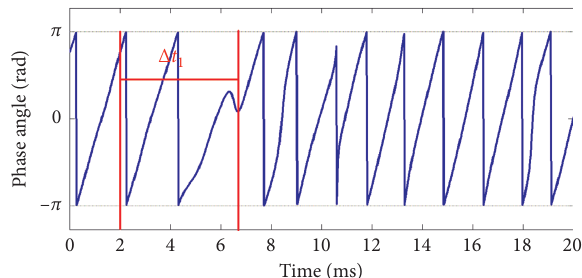
Figure 14: Time-phase angle curve with the frequency of 440Hz.